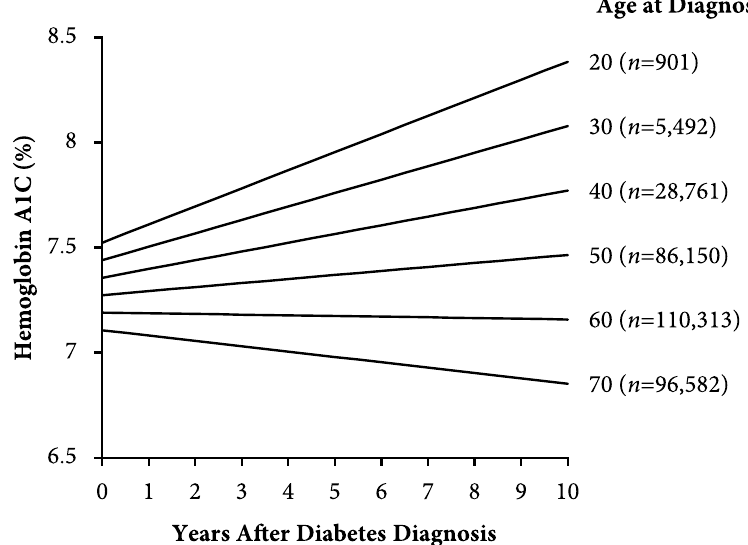
Fig 2. Glycemic deterioration during the first decade after type 2 diabetes diagnosis. Results are stratified by age at diagnosis (population cohort, Hong Kong Diabetes Surveillance Database, 2002–2016). Glycemic deterioration is the modeled slope of the A1C over time after adjusting for oral glucose-lowering drug prescriptions. The sample size ( n ) is indicated for each age group (age at diagnosis < 25, 25–34, 35–44, 45–54, 55–64, � 65 years). See Table C in S1 Appendix for numeric values. A1C, hemoglobin A 1c .